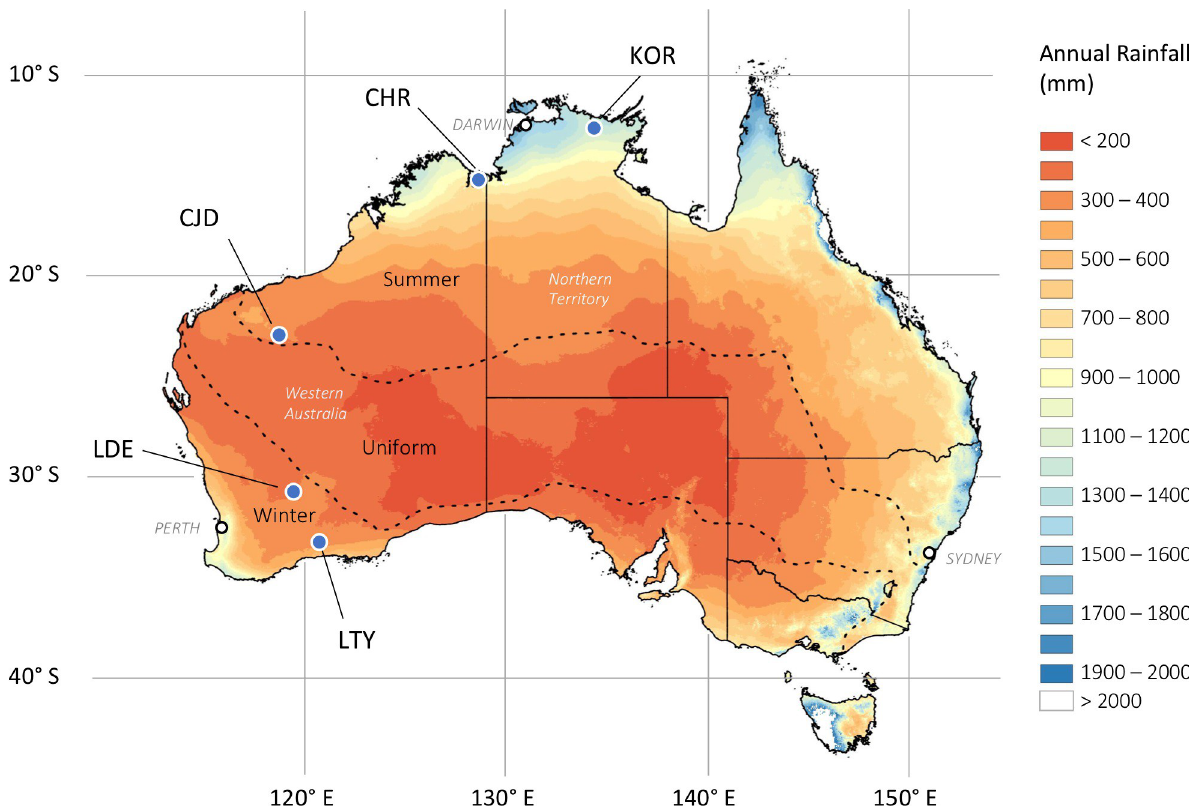
Fig 1. Location of five Callitris columellaris tree-ring sites in relation to annual rainfall and rainfall seasonality zones of Australia. Coloured shading indicates the 1961–1990 mean annual (January to December) rainfall amount (Data sourced from the Australian Bureau of